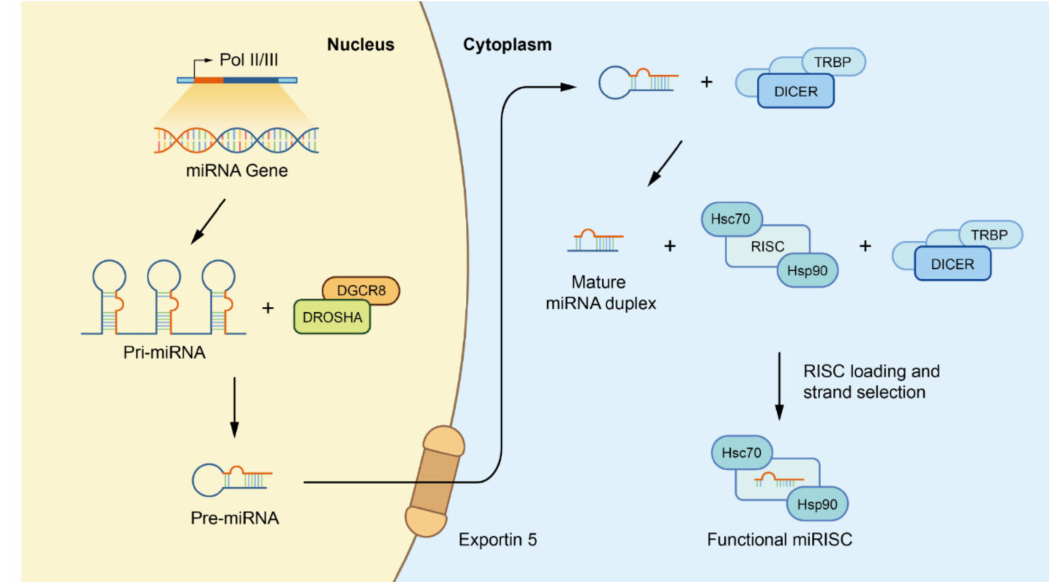
Figure 1. Canonical biogenesis of miRNAs. Firstly, miRNA genes are transcribed as primary precursors (pri-miRNA) by the action of RNA polymerase and further processed by the Drosha complex, which consists of one ribonuclease called Drosha and two molecules of the RNA-binding protein DGCR8, to form pre-miRNAs. Subsequently, pre miRNAs are exported to the cytoplasm by exportin-5 at the nuclear envelope before being cleaved by the Dicer/TRBP complex to form mature miRNA duplexes. Finally, with the help of the Dicer/TRBP complex and HSC70/HSP90 chaperone proteins, one strand of the miRNA duplex is placed into the RISC to form a functional miRISC for subsequent regulation. Abbreviations: miRNAs: microRNAs; pri-miRNA: primary miRNA; DGCR8: DiGeorge syndrome critical region 8; pre-miRNAs: precursor miRNAs; TRBP: transactivation response RNA binding protein; HSC70: heat shock cognate protein 70; HSP90: heat shock cognate protein 90; RISC: miRNA induced silencing